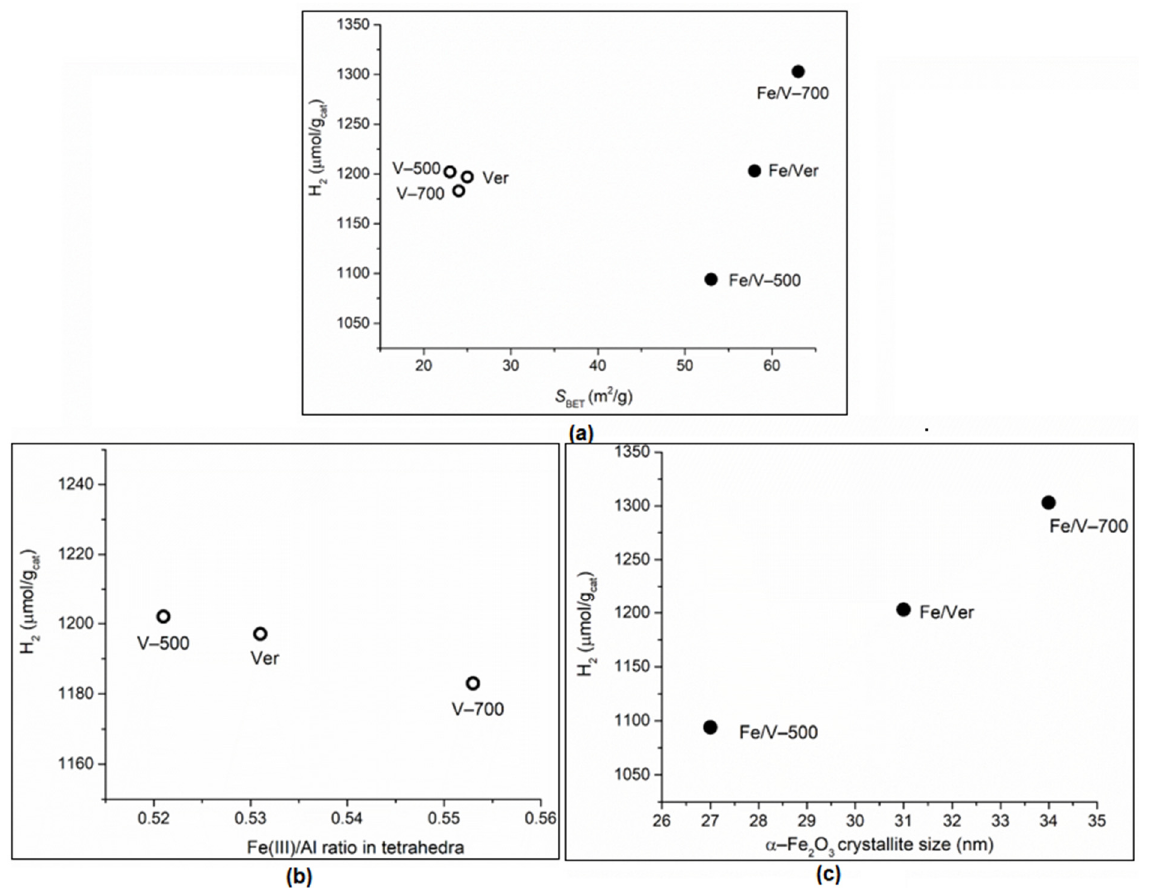
Figure 8. The yields of hydrogen in the presence of investigated photocatalysts dependency on: ( a ) the surface area ( S BET ), ( b ) Fe(III)/Al ratio in tetrahedral position of vermiculite samples and ( c ) the mean crystallite size D (012) of α -Fe 2 O 3 nanoparticles anchored in nanocomposite samples.